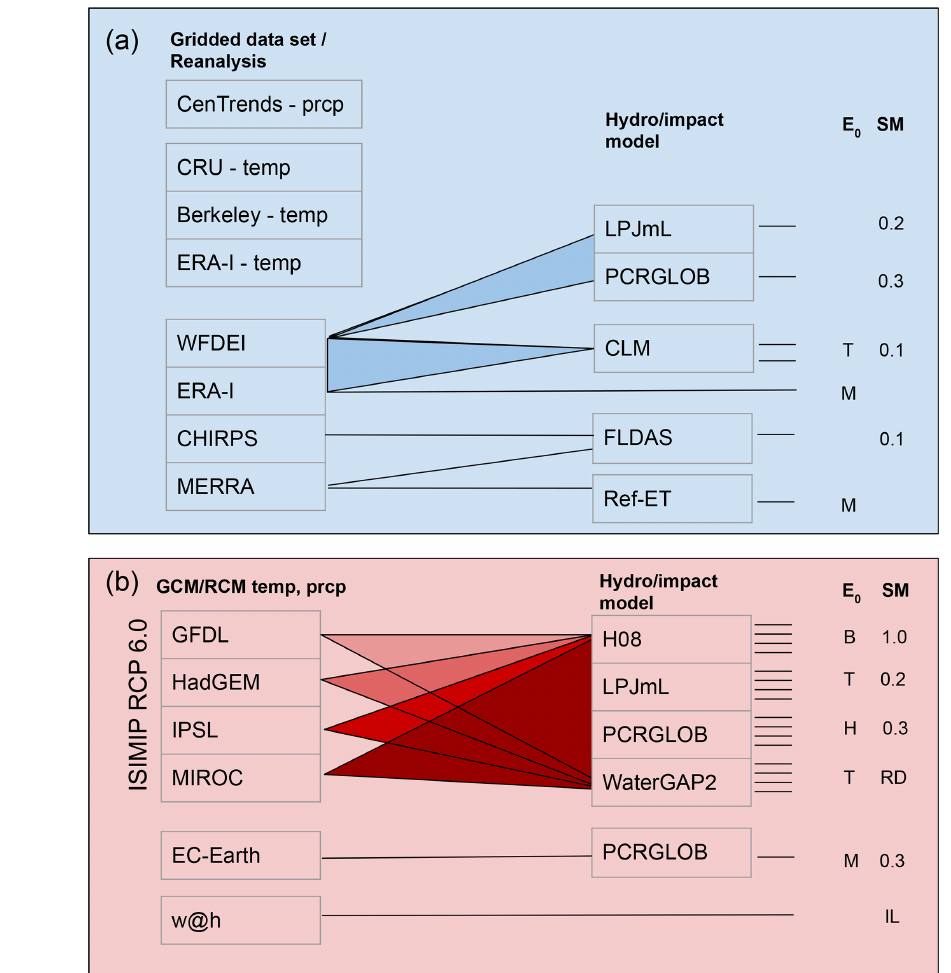
Figure 2. Datasets used in this paper. (a) Observational precipitation (prcp) and near-surface temperature (temp) datasets and (b) models. Listed under E 0 is the E 0 scheme (T: Priestley–Taylor; M: Penman–Monteith; H: Hamon; B: bulk formula) and under SM is the depth of the top soil moisture layer available (RD: depends on rooting depth, 0.1–1.5m for WaterGAP2; IL: integrated over all layers). Shading indicates an experiment with either multiple input datasets or multiple hydrological models. The number of resulting hydrological model simulations are indicated by horizontal lines on the right side of the